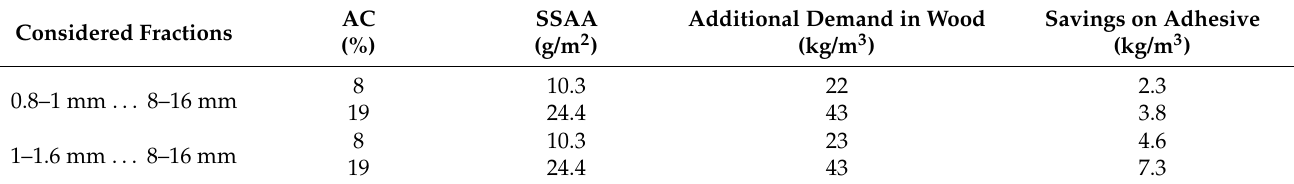
Table 4 provides an overview of the results up to this point. Table 4. Results